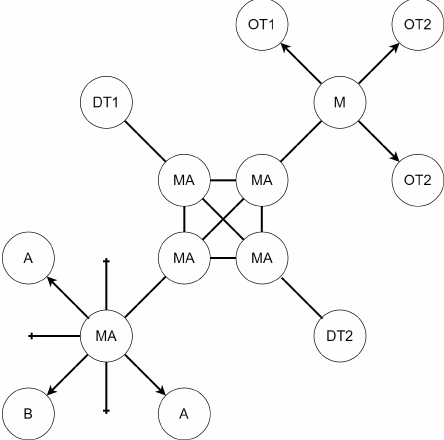
Figure 11. The initial state of a system in the example of checking whether non-functional require- ments are met. Table 19. Interpretation of controls in the example of checking whether non-functional requirements are satisfied.